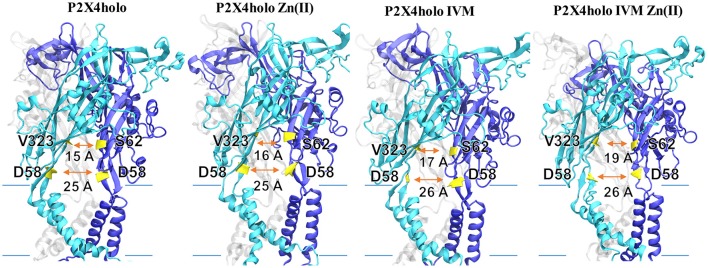
Lateral fenestration dimension of P2X4R in different states. Models represent the P2X4R holo state with either Zn(II), IVM, or both bound. Lateral fenestration size was calculated in the apo as well as the holo state, holo in the presence of Zn(II) or IVM, or holo plus IVM and Zn(II). Backbone distance between D58 with its corresponding D58 in the adjacent P2X4R subunit was considered. Likewise, the backbone distances between V323 with S62 in the adjacent subunit were determined. Lateral fenestration dimensions are expressed in Å.